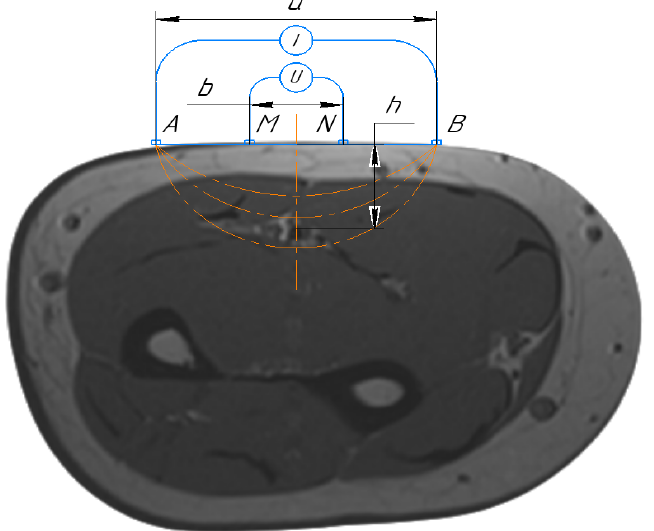
Figure 2. Schematic diagram of the four ‐ electrode setup. A and B are the current electrodes, M and N are the measuring electrodes. N are the measuring